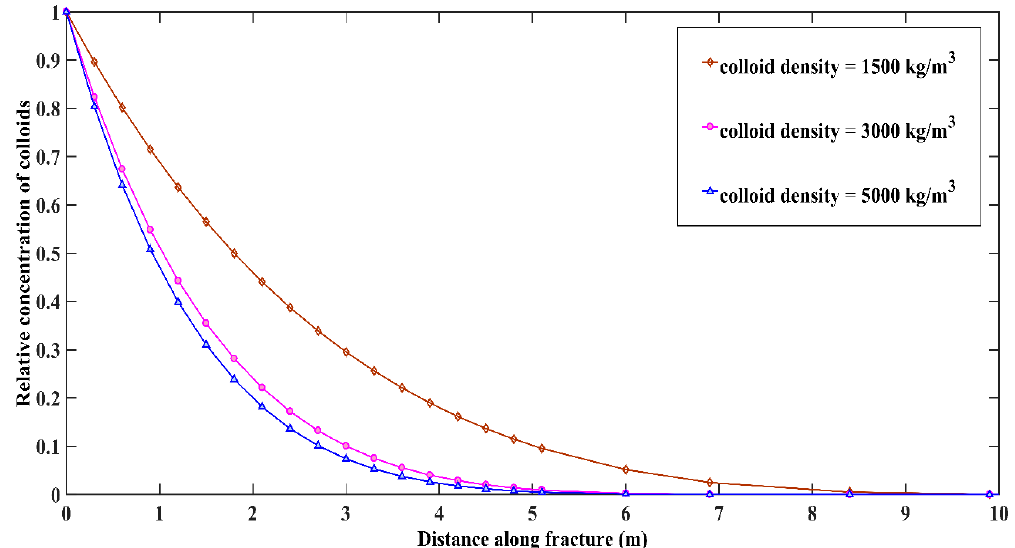
Figure 5. Spatial distribution of relative concentration of colloids along fracture at three different values of colloid densities (1500 kg/m 3 , 3000 kg/m 3 and 5000 kg/m 3 ), at 300 nm colloid